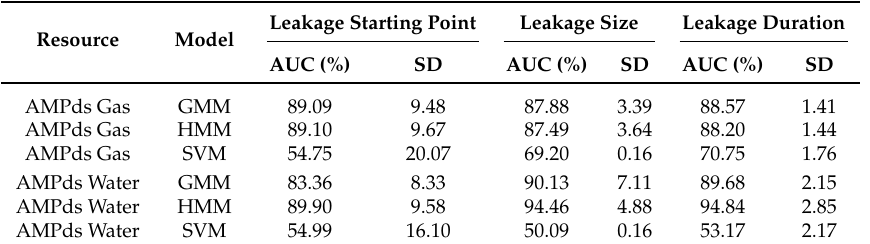
Table 7. Performance of the variability tests.